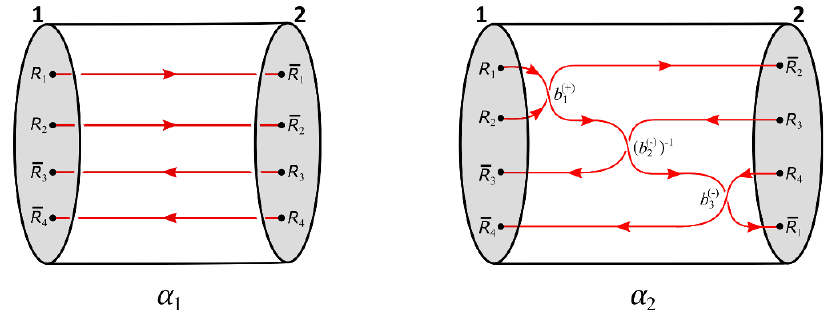
by applying a series of braiding operators α 1 | (cid:30)